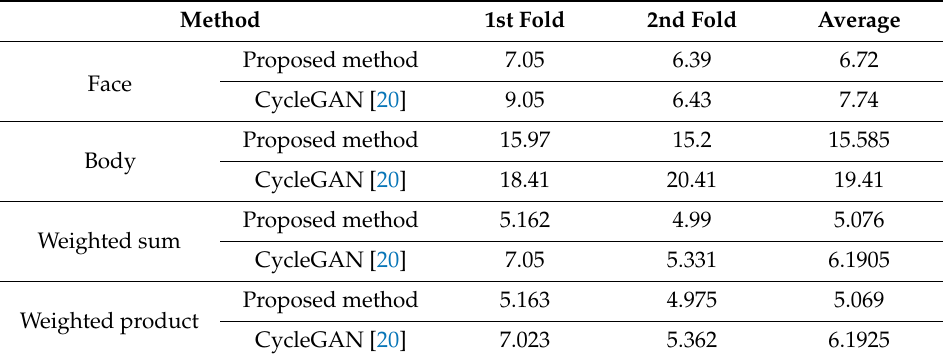
Table 12. Comparisons of EER for recognition by proposed method with that by CycleGAN (unit: %).